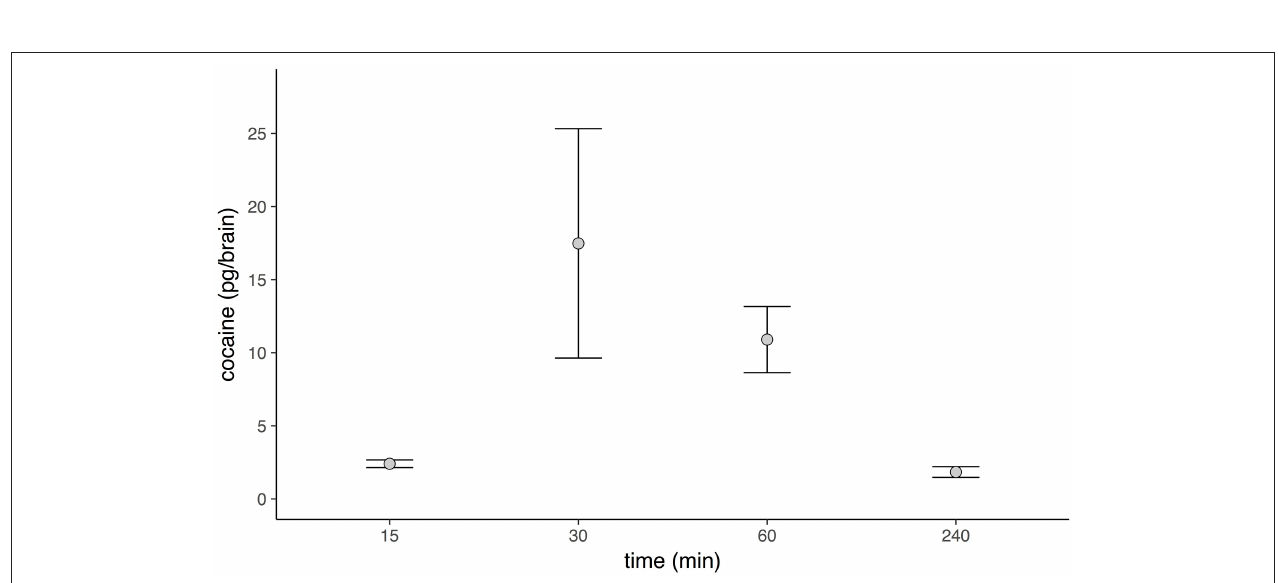
FIGURE 8 | Amounts of cocaine in the honey bee brain after topical treatment. Levels of cocaine increased sharply 30min after treatment, thereafter levels gradually decreased, until they were almost absent at 4h.